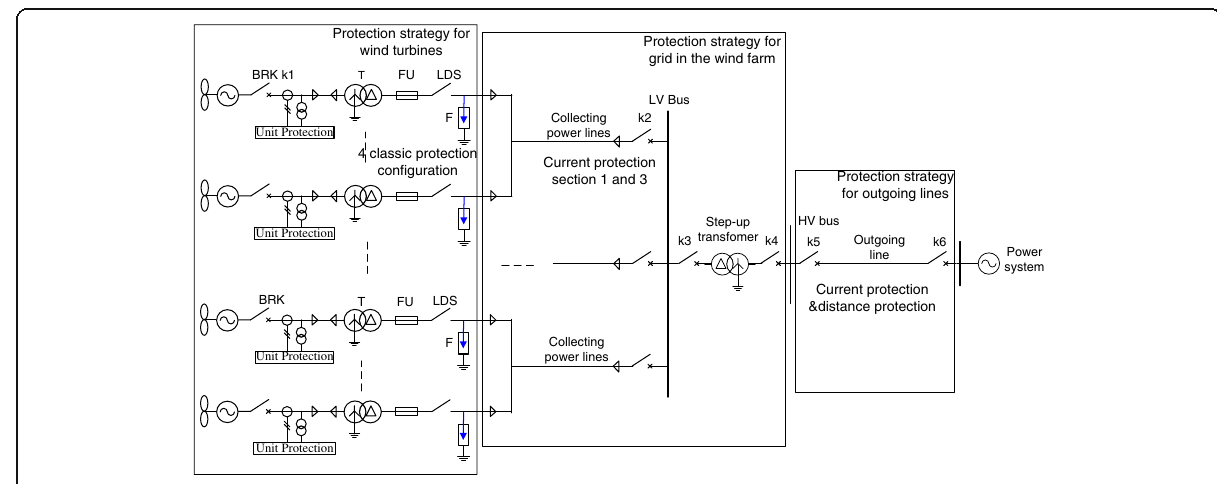
Fig. 4 Protection configuration for PSMG wind